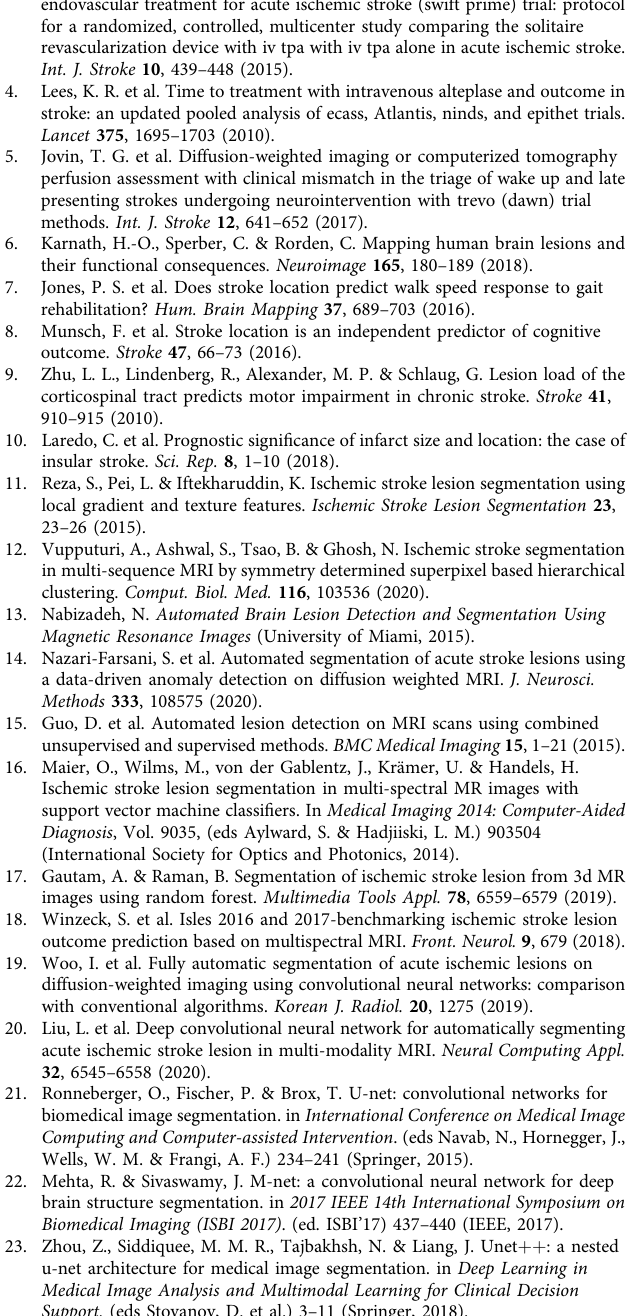
Fig. 7 Illustrative cases of models ’ performances. Columns from the left to the right: DWI, ADC, and overlays on DWI of the manual delineation (red), DeepMedic Predicts (yellow), DAGMNet_CH3 (our proposed model) predicts (blue), UNet_Ch3 (green), and FCN_CH3 (purple). A Typical lesion. B Case with inhomogeneity between DWI slices; note the high agreement of our proposed model with the manual annotation. C Multifocal lesions. D Small cortical lesion, detected exclusively by DeepMedic and our proposed attention model. E – G Typical false positives (arrows) of other models (DeepMedic in particular) in areas of: E “ physiological" high DWI intensities; F DWI artifacts in tissue interfaces; in addition to the cortical areas, this was vastly observed in the basal brain, along the sinuses interfaces, and in the plexus choroids; G in possible chronic microvascular white matter lesions. H , I Cases in which the retrospective analysis favored the automated prediction, rather than the human evaluation for: H lesion delineation, and I lesion prediction (this case was initially categorized by evaluators as “ not visible" lesion, but the small lesion predicted by our model was con fi rmed by follow-up). J Lesion of high-intense core but subtle boundary contrast, which ameliorates the discriminative power of all 3D networks. In this case, the patch-wise DeepMedic had the best agreement with manual annotation in the boundaries at the cost of detecting false positives